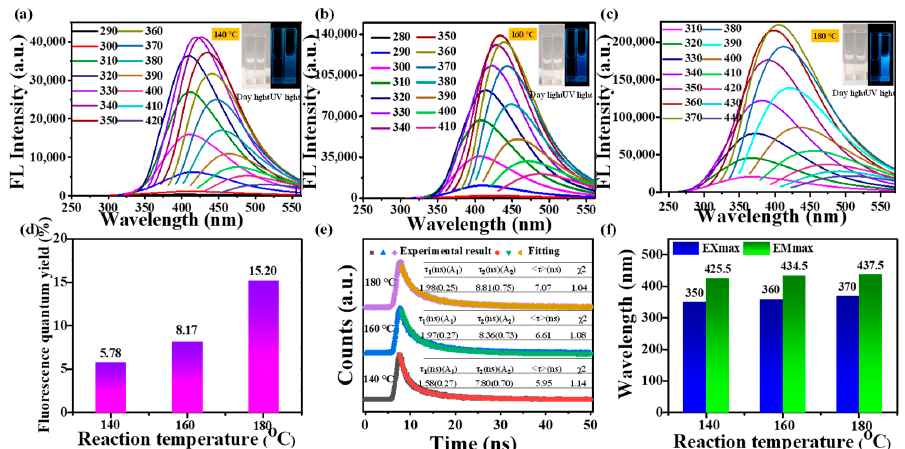
Figure 5. ( a – c ) Fluorescence emission spectra (the photographs of CDs water solutions under daylight and UV light were shown at the insets), ( d ) fluorescence quantum yield of mussels-derived CDs fabricated at 140 °C, 160 °C, and 180 °C, respectively, ( e ) fluorescence decay and fitting curves, ( f ) Ex max and Em max of mussels-derived CDs fabricated at 140 °C, 160 °C, and 180 °C, respectively. In addition, the average lifetime of CDs prepared at 140, 160, and 180 °C were measured to be 5.94, 6.61, and 7.07 ns, respectively, with fitted value χ 2 < 1.2 (Figure 5c). The fluorescence lifetime was a reflection of the time it takes for the molecule to absorb energy and then return to the ground state [32]. The above results clearly confirm that the excited state of CDs was more stable along with the reaction temperature increasing.